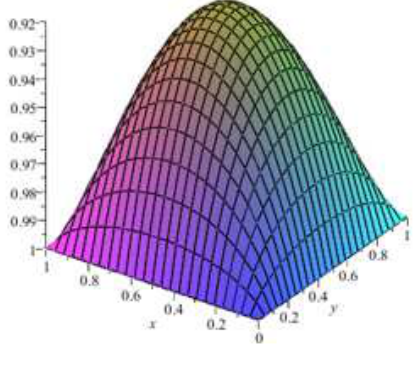
Fig. 3 Solution of NPB equation at